Question: What does this figure show? Answer in one sentence.
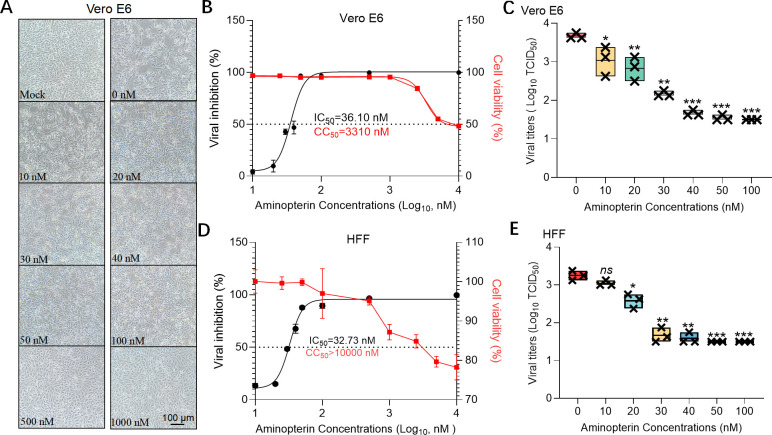
Answer: Aminopterin potently inhibits MPXV replication in vitro . ( A ) Morphological analysis of MPXV-infected Vero E6 cells (1 × 10 4 PFU) treated with aminopterin (0–1 μM, 48 h) by light microscopy (scale bar: 100 μm). ( B and D ) CC 50 and IC 50 of aminopterin were calculated by linear regression analysis of the viral DNA inhibition curves in Vero E6 and HFF cells, using qPCR assay. SI value was defined as the ratio of CC 50 to IC 50 (CC 50 /IC 50 ; n = 3, independent experiments). ( C and E ) Infectious viral titers in supernatants from panels B and D were determined by TCID 50 assay ( n = 3, independent experiments). Data expressed as means of technical replicates ± SD, and one-way analysis of variance ( C and E ) and SNK-q test ( C and E ) were performed in this section (* P < 0.05, ** P < 0.01, and *** P < 0.001 , ns: not significant).